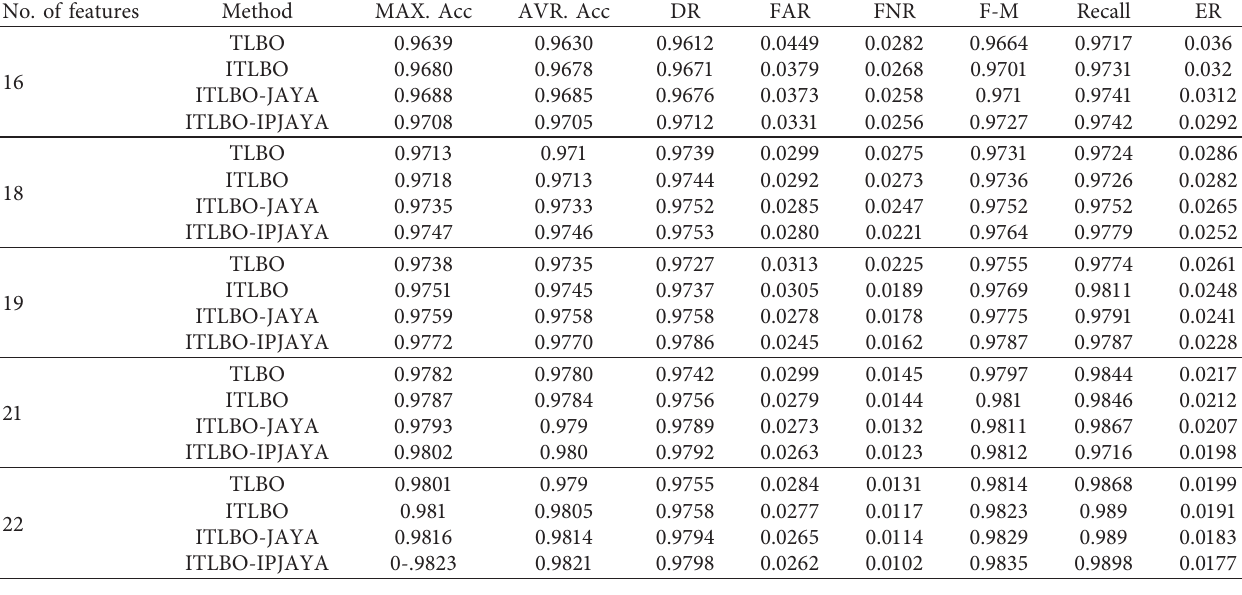
Table 11: Comparison of ITLBO, ITLBO-JAYA and ITLBO-IPJAYA for the NSL-KDD dataset.